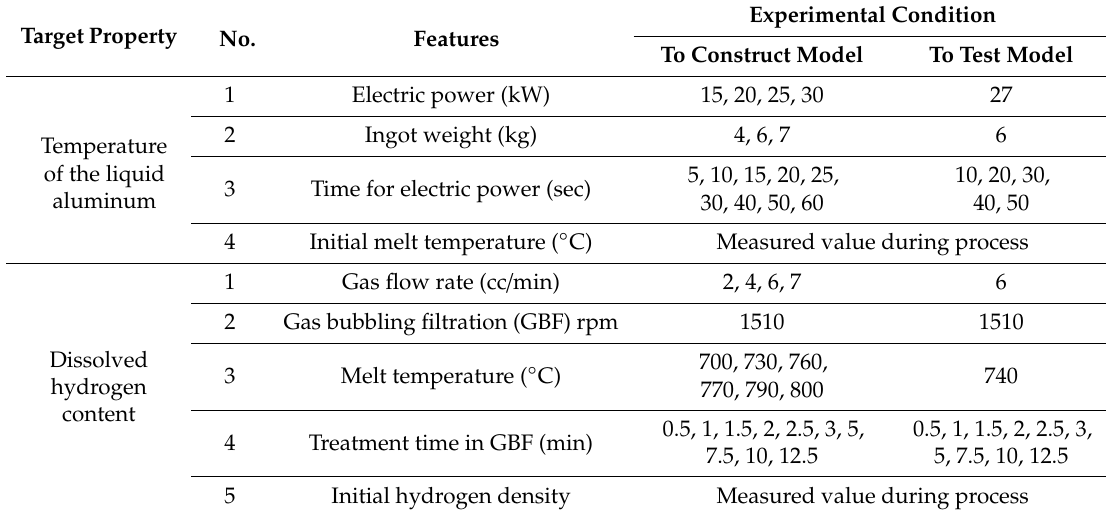
Table 1. Process parameters to construct machine learning models for the temperature of the liquid aluminum and the dissolved hydrogen content in the liquid